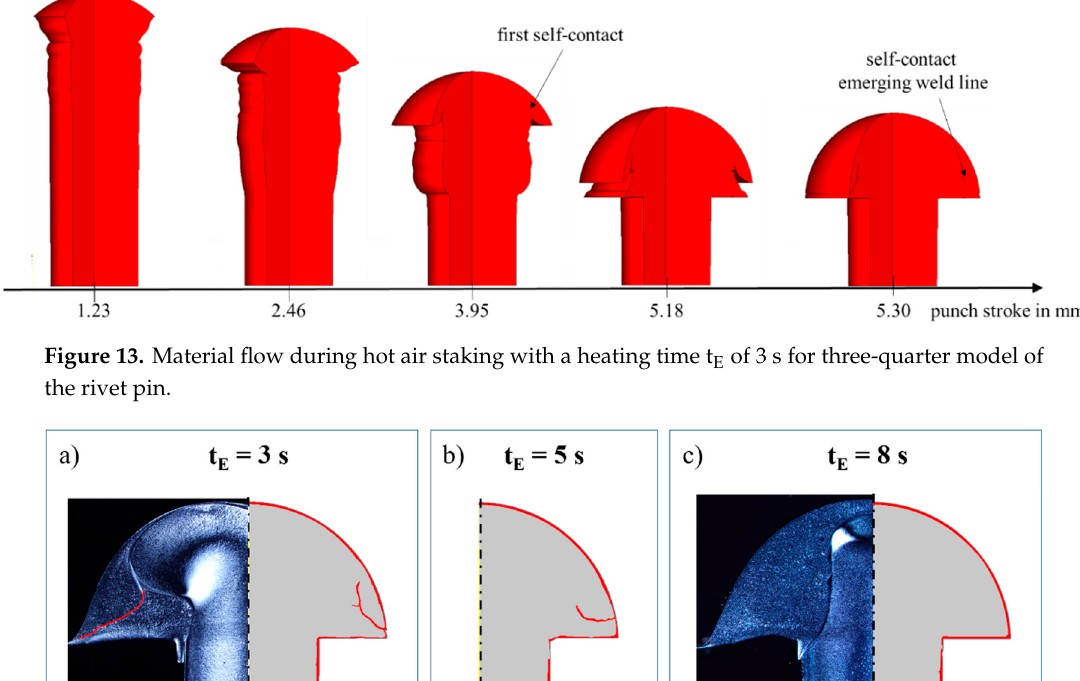
Figure 13. Material flow during hot air staking with a heating time t E of 3 s for three-quarter model of the rivet pin.